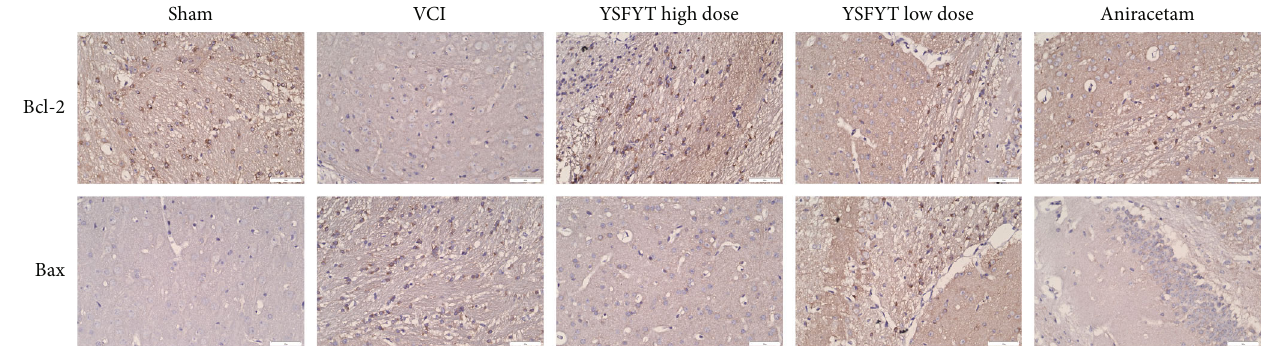
Figure 6: Immunohistochemistry was used to detect the expressions of antiapoptotic protein Bcl-2 and proapoptotic protein Bax in hippocampus of each group. Brown indicates the positive part. The scale bar is 50 μ